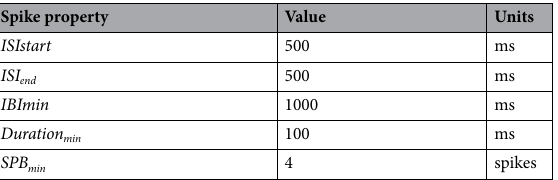
Table 4. Max interval spike sorting properties used by the burst calculation algorithm. ISI Interspike Interval, IBI Interburst Interval, SPB spiked per